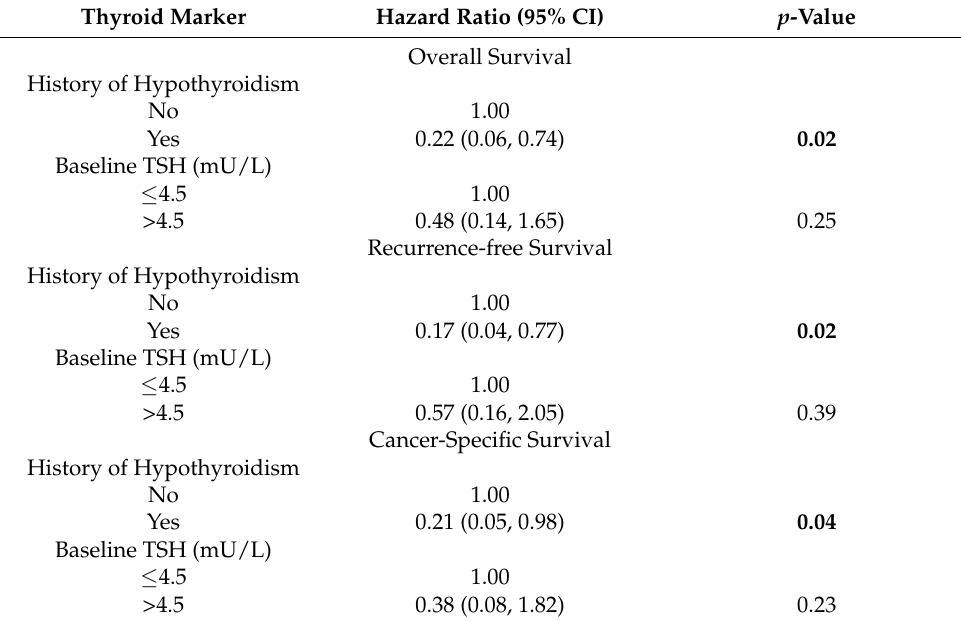
Table 4. Adjusted Cox regression analysis of TSH prognostic groupings and survival from endome- trial